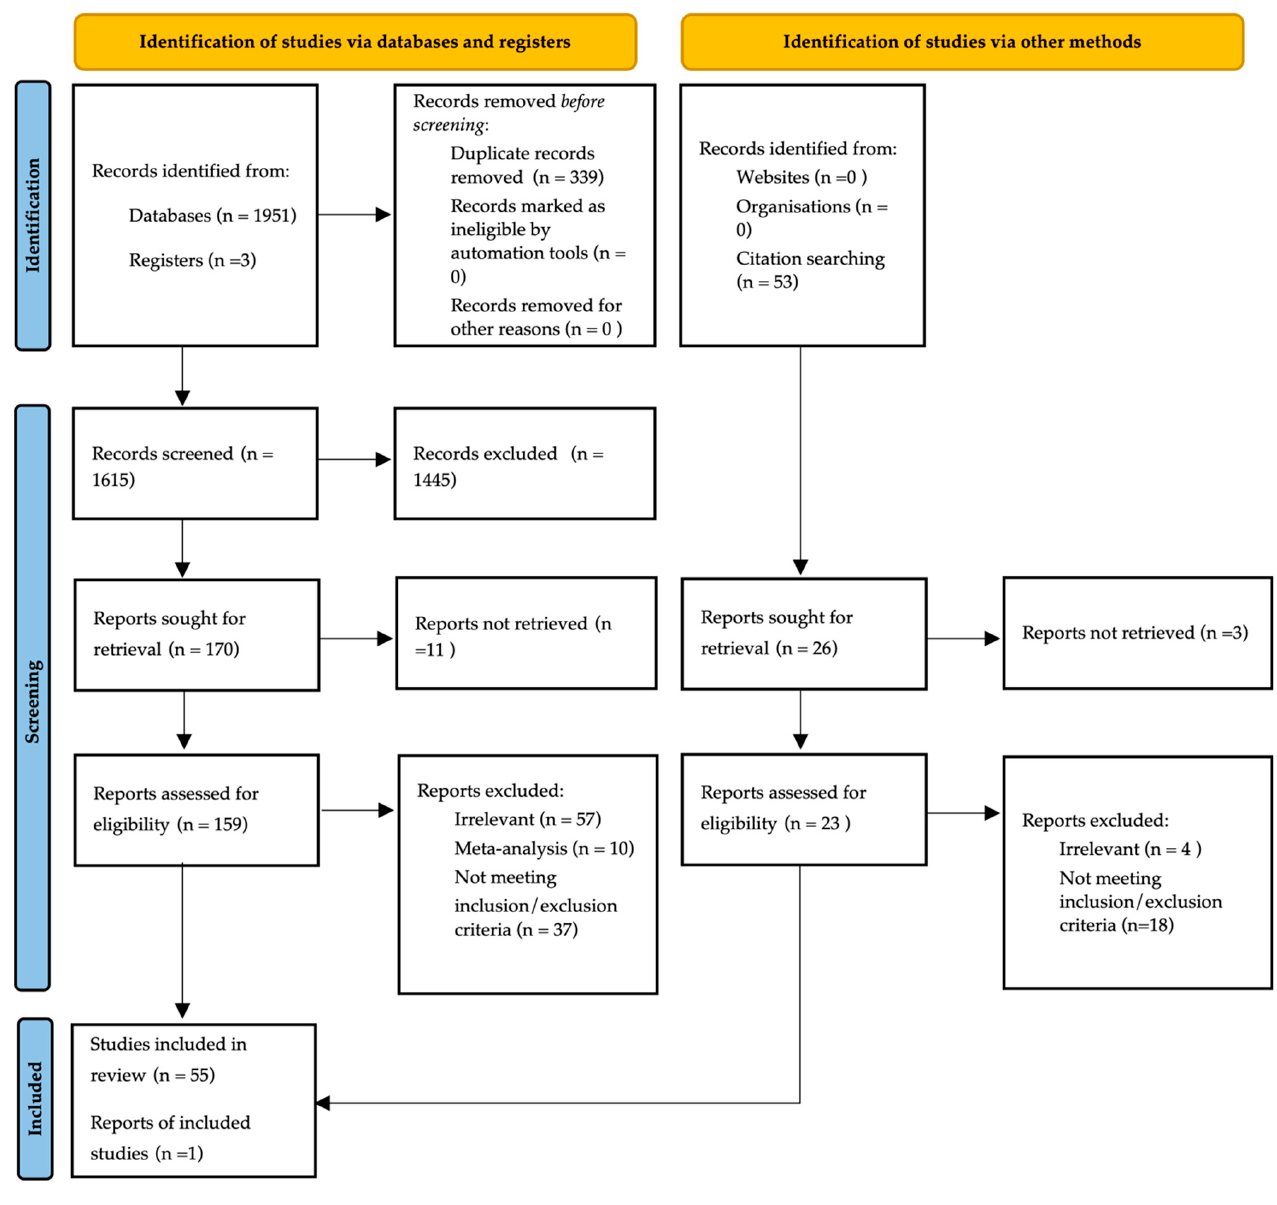
Figure 1. Flowchart of the search strategy.